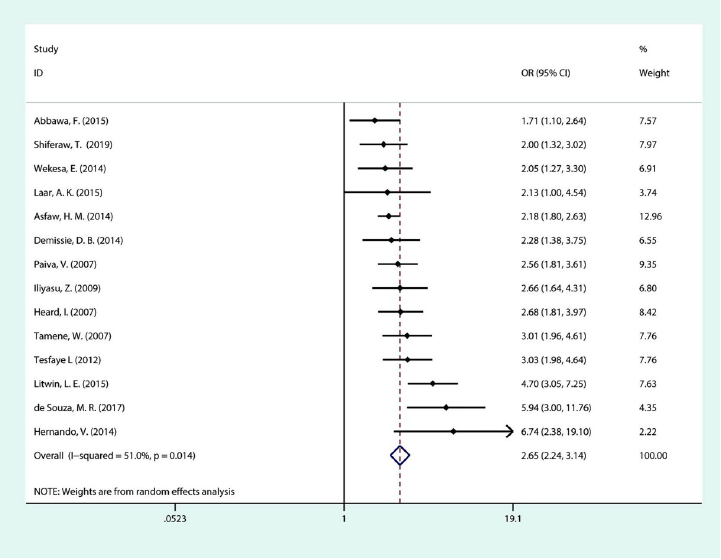
Fig 5. Forest plot of pooled OR for fertility desire in PLHIV (aged below 30 years vs aged 30 and above).